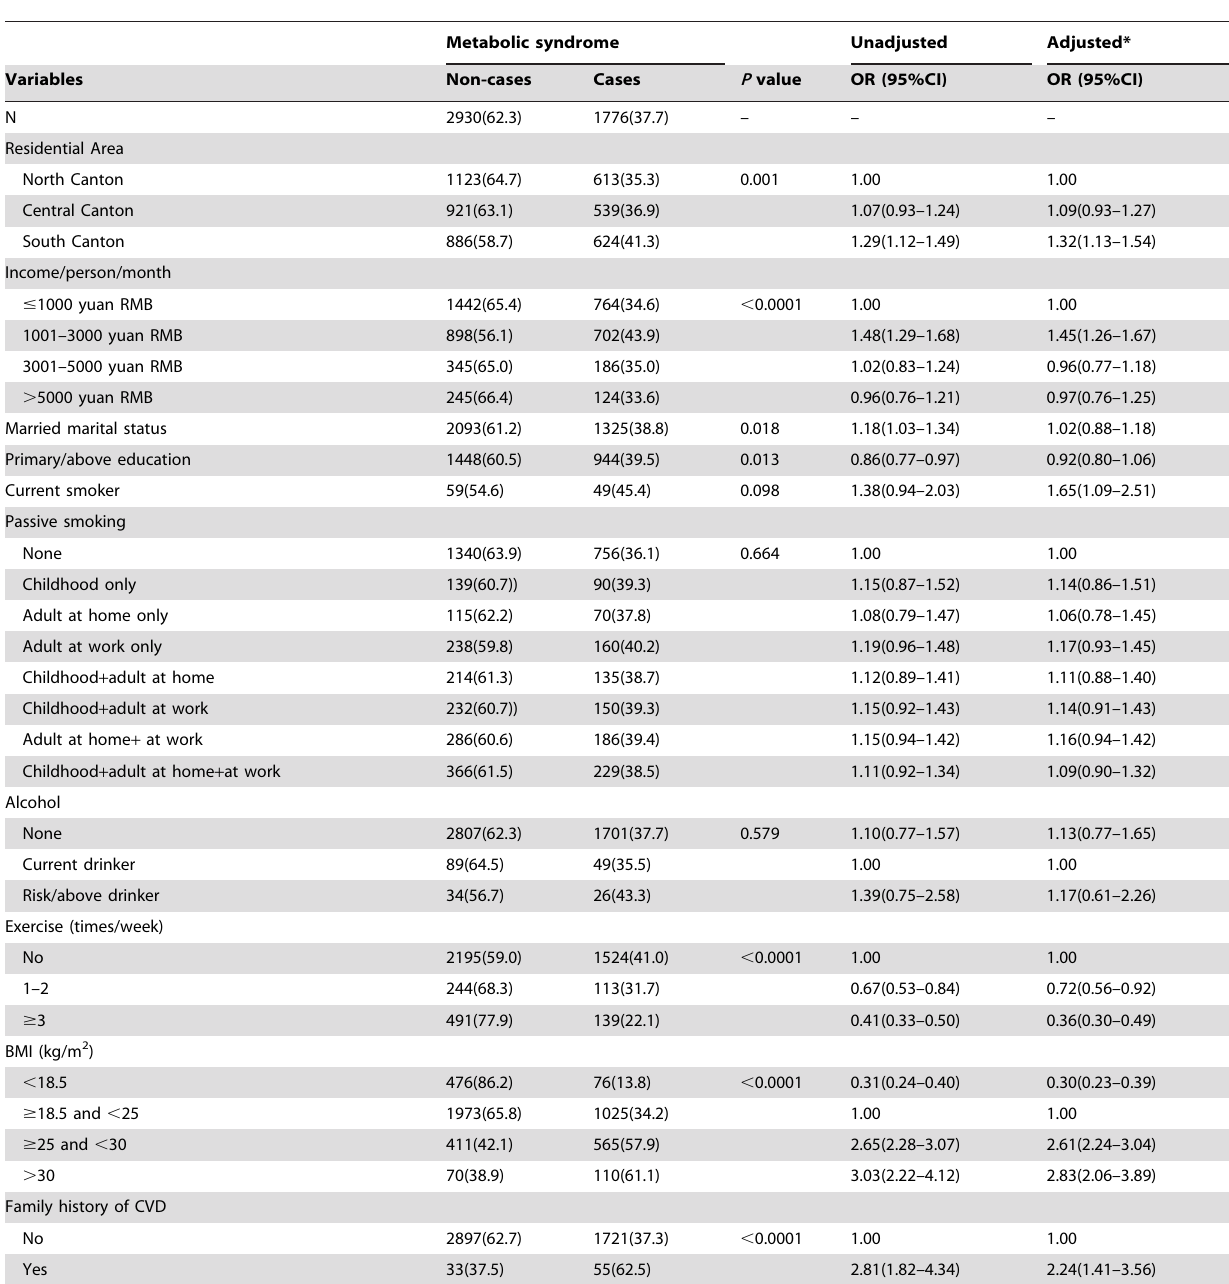
Table 2. Factors associated with metabolic syndrome according to JIS criteria among postmenopausal women in rural Canton